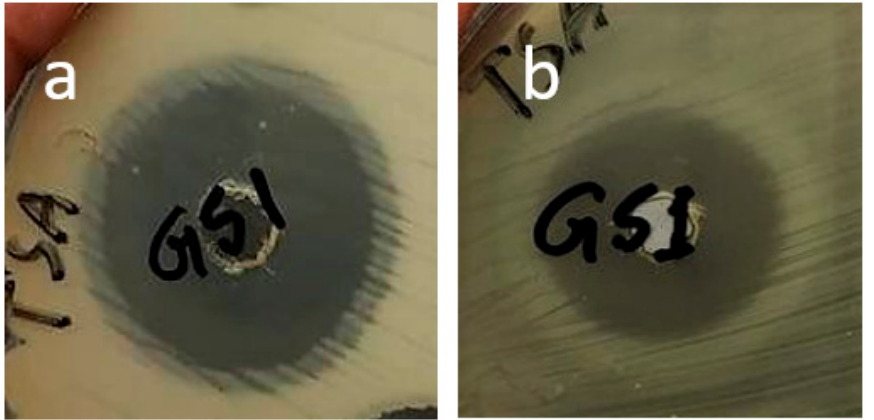
Figure 12. Antibacterial activity of drug loaded hydrogel film showing the inhibition zone for ( a ) S. aureus and ( b ) E. coli bacteria . Table 3. Zone of inhibition (mm) in drug loaded hydrogel sample